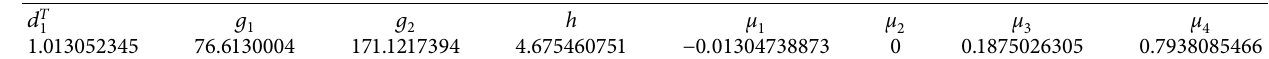
Table 5: The parameters calculated in system (4).